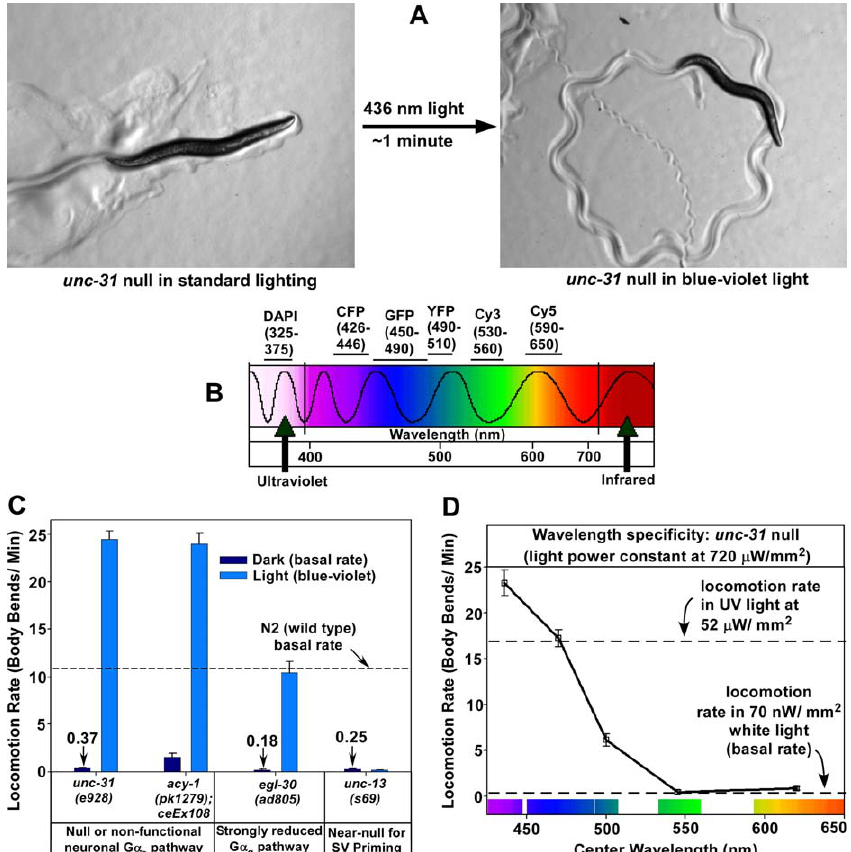
Figure 1. Blue Light–Mediated Rescue of Paralyzed Synaptic Signaling Mutants (A) Images show an unc-31 null mutant on a bacterial lawn before and after illumination with 436-nm light. (B) Filters for determining the wavelength specificity of the light response. Lines above the visible light spectrum indicate the wavelength range of light that each filter transmits to the microscope objective (numbers are wavelengths in nanometers). The filter names refer to chromophores that are irrelevant to these studies. Chroma filter numbers (from lowest to highest wavelengths): 31000v2, 31044v2, 41017, 41028, 41007a, and 41008. (C) Mean locomotion rates of representative synaptic signaling mutants in low white light versus blue-violet light of optimal power (1460 l W/mm 2 ). Numbers above some bars state the precise locomotion rates. Error bars are the standard errors of ten animals. (D) Mean locomotion rates of an unc-31 null mutant illuminated with various wavelengths. Error bars are the standard errors of ten animals.